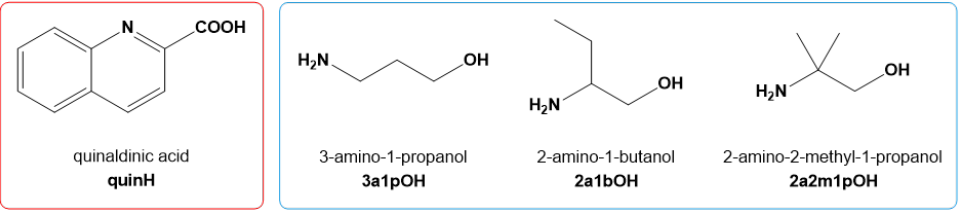
Figure 1. Structural formulae of quinaldinic acid, 3-amino-1-propanol, 2-amino-1-butanol, and 2-amino-2-methyl-1-propanol.